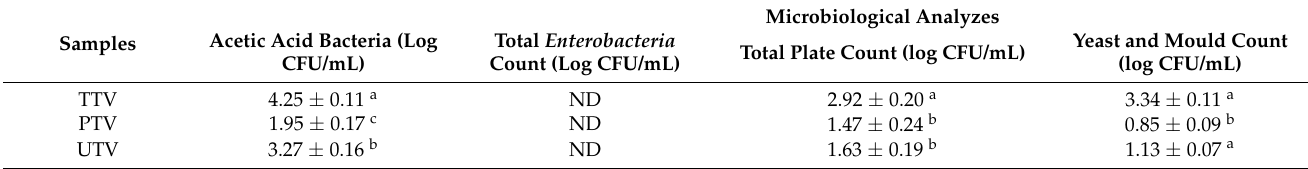
Table 6. Effects of thermal treatment and ultrasound on microbial analysis of tomato vinegar.